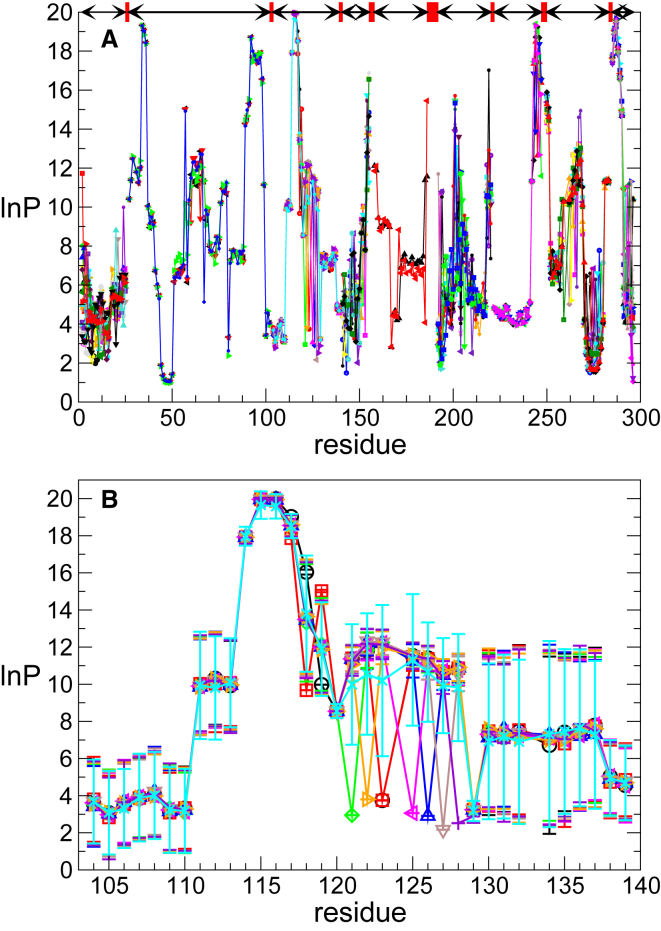
Results of cluster analysis. Sets of estimated multivariate means for ln(P) are shown. (A) Top shows the results for all contiguous regions (i.e., regions of the polypeptide chain covered by overlapping peptides) as arrows with red boxes representing gaps between these regions. Per contiguous region, a colored curve represents one set of multivariate solutions across the residues of this region. The multivariate means for each cluster (represented by a Gaussian) are shown in different colors. Note, fewer colors are used in regions with few well-defined solutions. (B) The nine sets of multivariate solutions obtained for the contiguous region encompassing residues 103–139 are shown. Error bars represent 1 SD. To see this figure in color, go online.